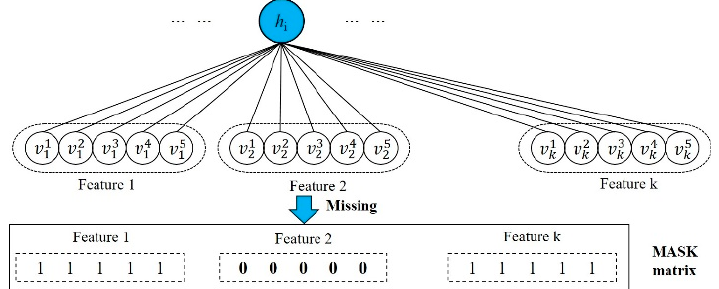
Figure 3. Data preprocessing based on the restricted Boltzmann machine (RBM) model.